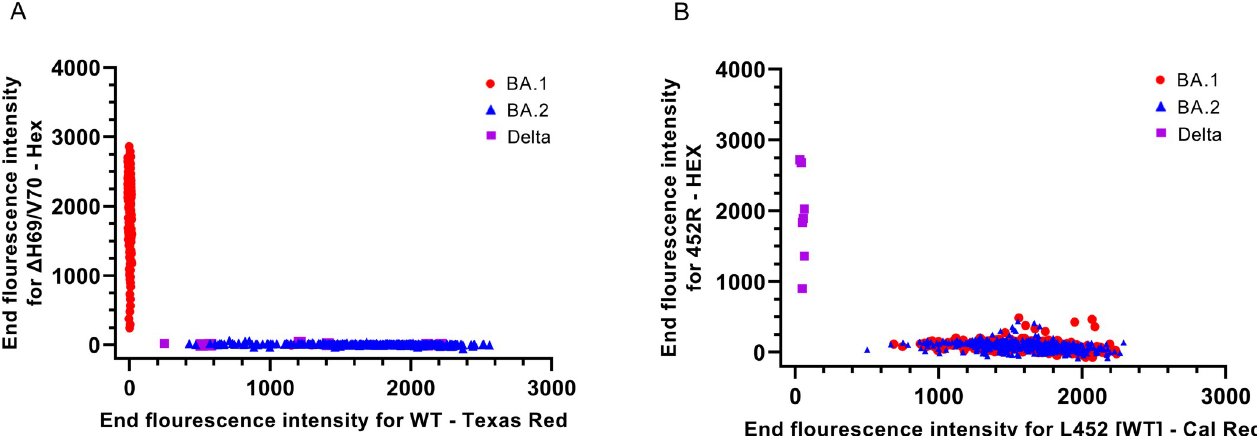
Fig 3. Detection of Δ H69/V70 and L452R mutations in BA.1 and BA.2. (A) Allelic discrimination analysis to differentiate between the H69/V70 deletion and the WT sequence. (B) Allelic discrimination analysis to differentiate between the 452R mutation and the L452 WT sequence.